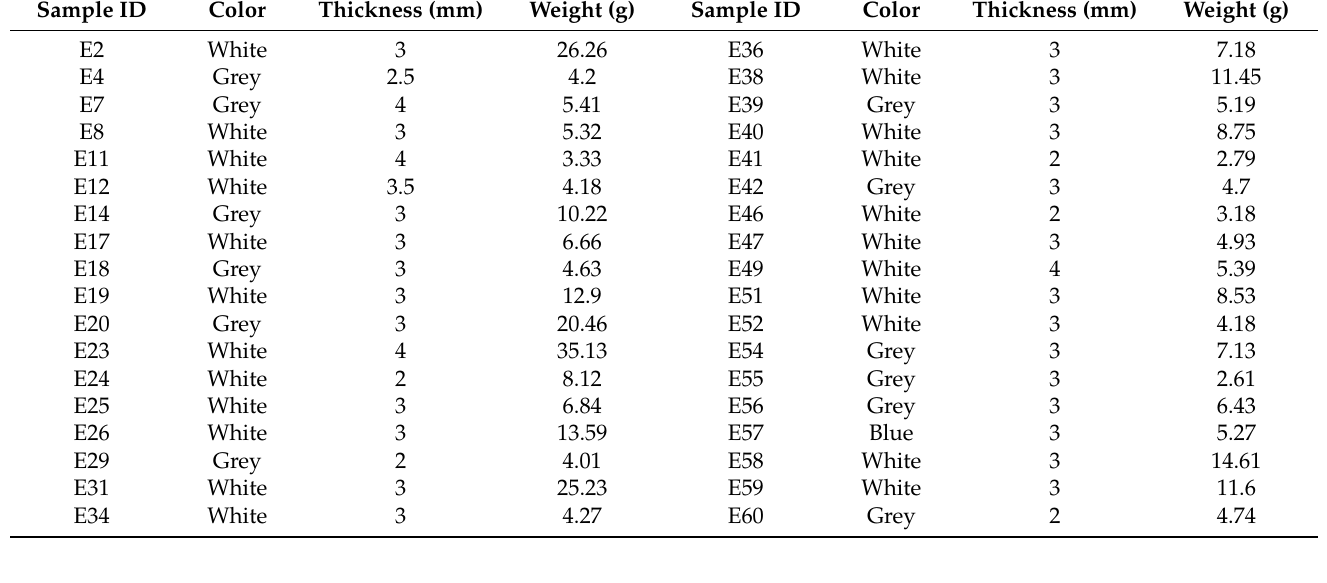
Table 1. Characteristics of the examined plastic scraps in respect of their physical attributes (color, thickness, and weight).